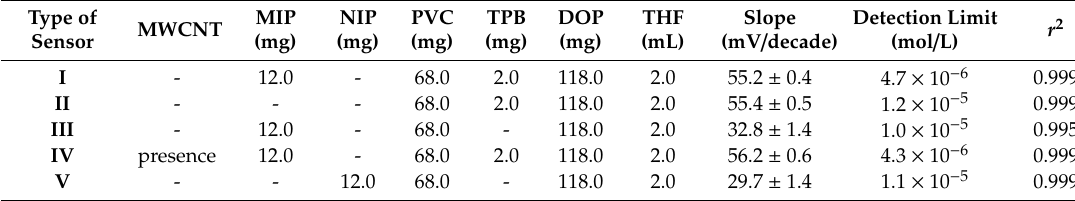
Table 1. The potentiometric response of FLV membranes sensor.